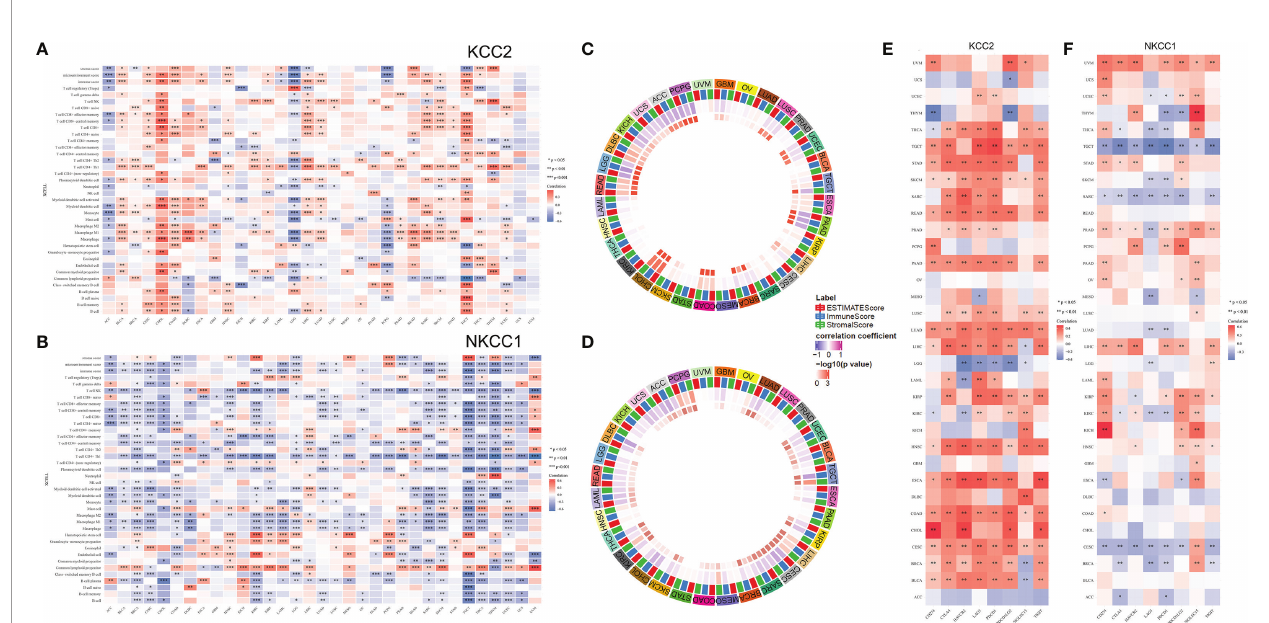
FIGURE 10 | Correlation analysis of KCC2 and NKCC1 with immune cells in fi ltration in TME of cancers. (A) Enrichment scores of all TME elements and KCC2 and NKCC1 in pan-cancer. (B) The relationship between the expression of NKCC1 and the number of immune cells. (C) The circus plot showed the correlation between expression of KCC2 and the estimated score, matrix score, and immune score in pan-cancer. (D) The circus plot showed the correlation between expression of NKCC1 and the estimated score, matrix score, and immune score in pan-cancer. (E) The relationship between KCC2 expression and immune checkpoint genes in pan-cancer. (F) The relationship between NKCC1 expression and immune checkpoint genes in